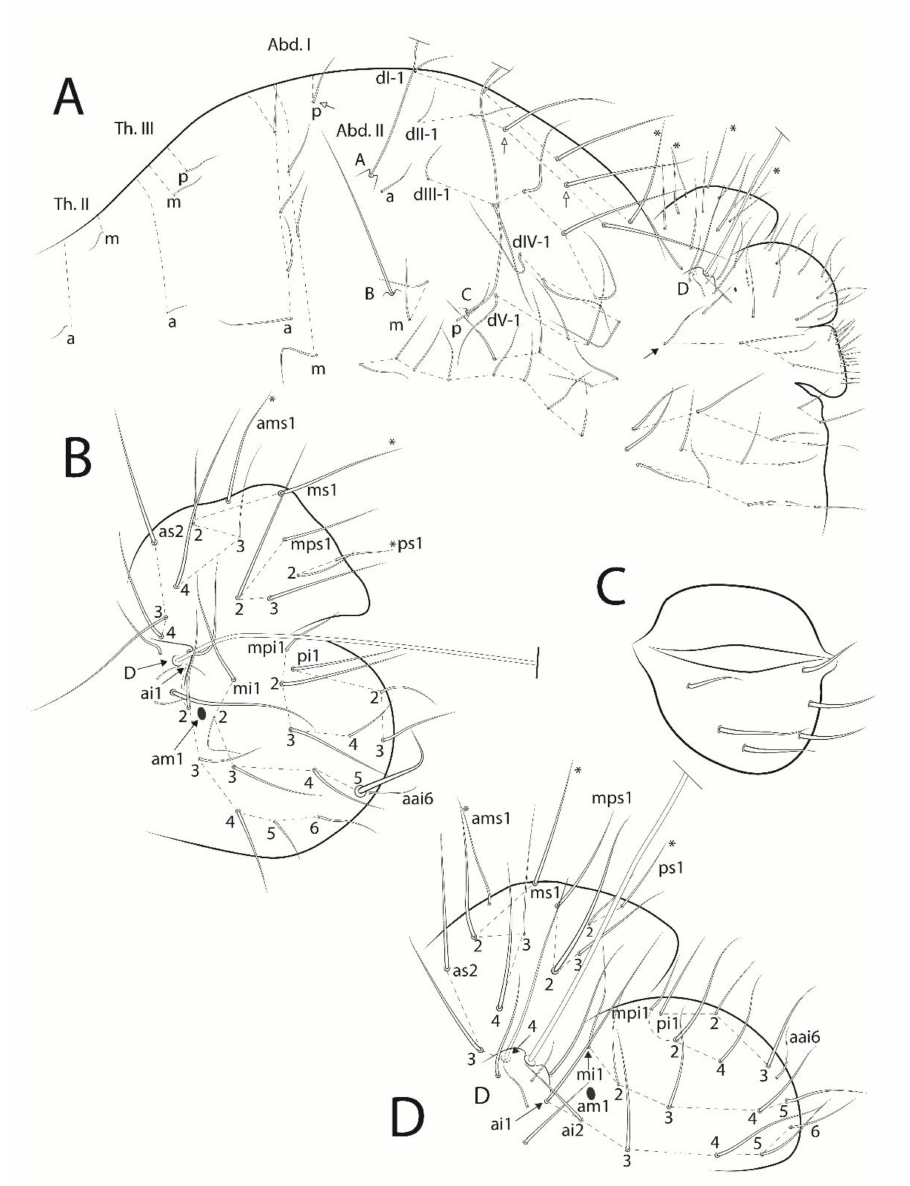
Figure 6. Troglobentosminthurus luridus gen. nov. sp. nov. trunk: ( A ) large and small abdomens of the male, white arrows mark chaetae present or absent, asterisks mark unpaired central chaetae, black arrow marks a row of chaetae only seen in males; ( B ) female’s small abdomen, asterisks mark unpaired central chaetae; ( C ) female’s genital plate; ( D ) male’s small abdomen in detail, asterisks mark unpaired central